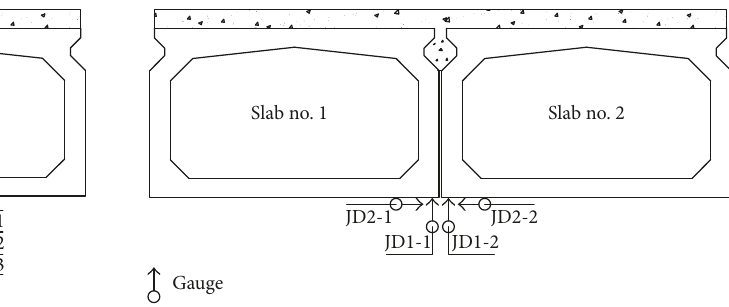
Figure 9: Displacement measurement points at the hinge joint.